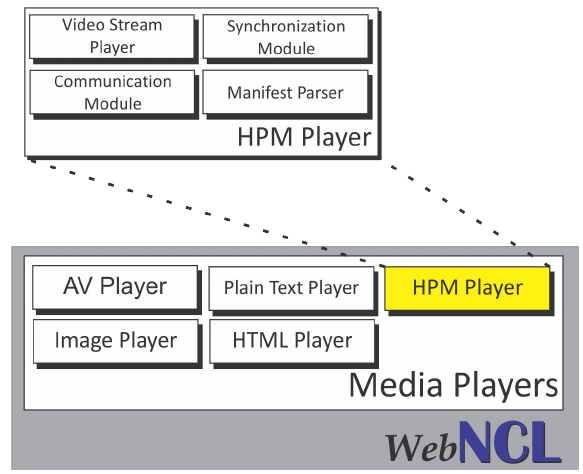
Figure 3. NCLweb and HPM Player